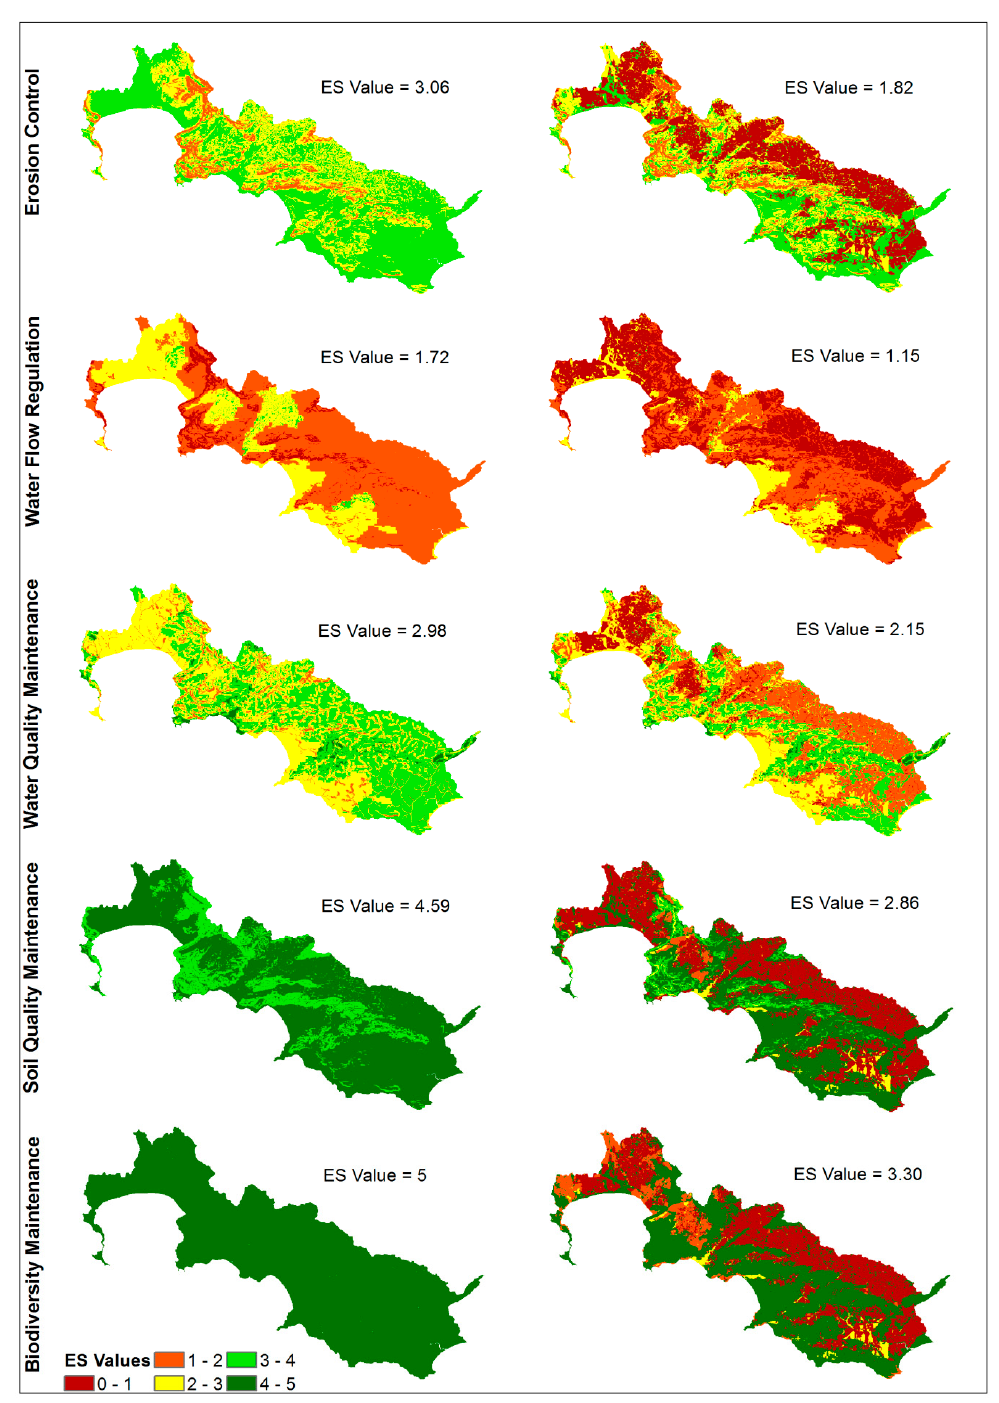
Figure 4. The values for different ecosystem services, reference (left) and LULC (right) maps.